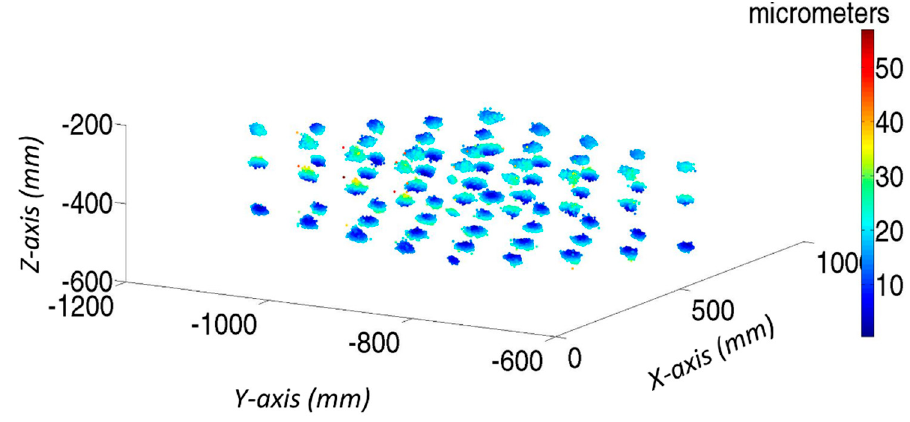
Figure 15. Final color map of verification points of 1000 tests on laser tracker coordinate system.